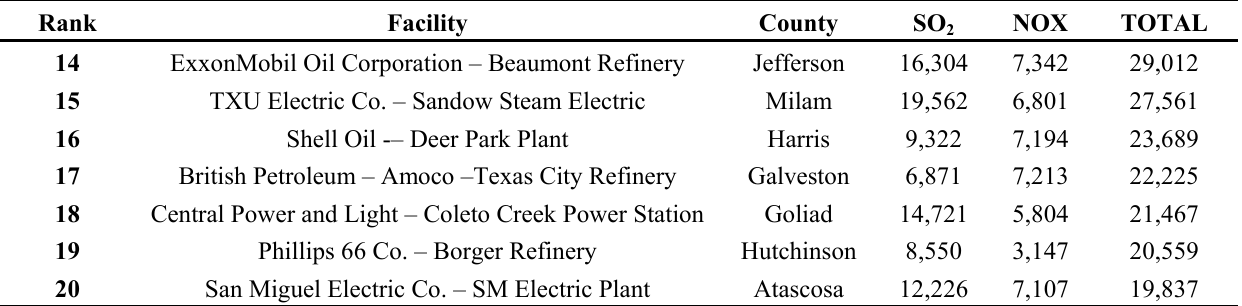
Table 7. Emissions Inventory: Top 20 Emitters of Criteria Pollutants in 2000 (In Tons).